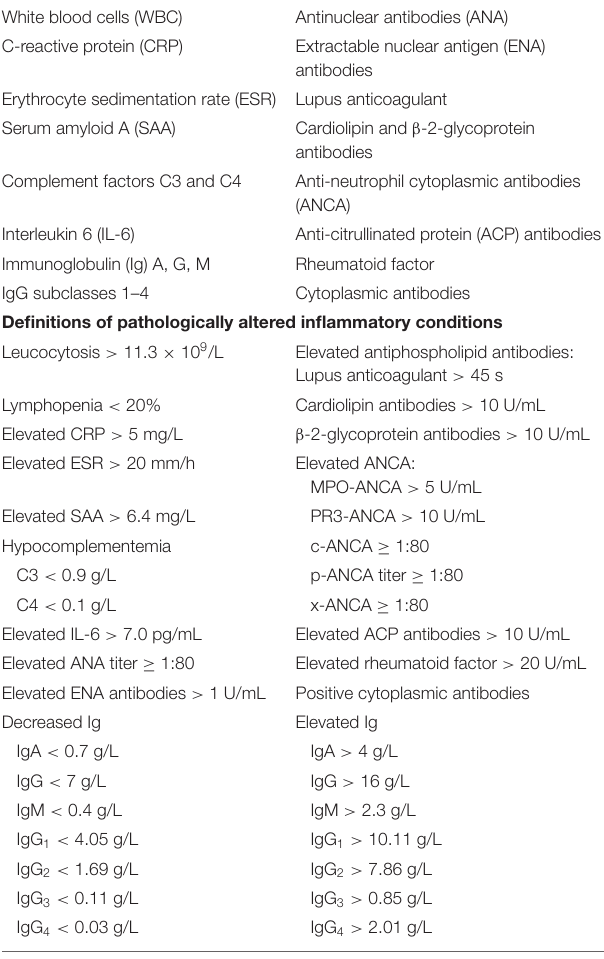
TABLE 1 | Immune-inflammatory parameters and cut-off values indicating potentially inflammatory conditions. White blood cells